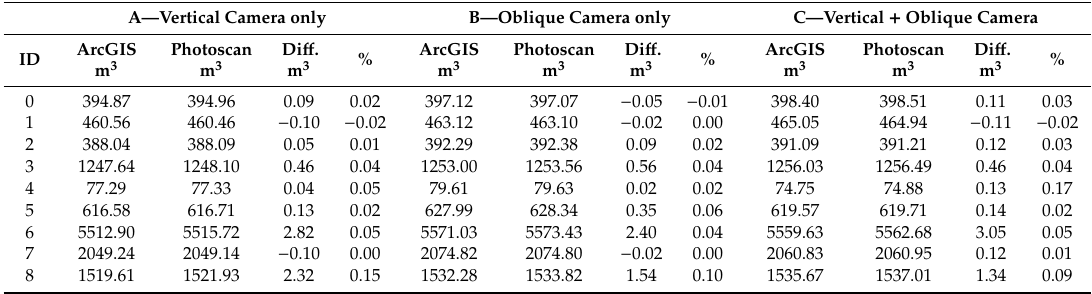
Table 5. ArcGIS vs. Photoscan volume computation in the three flight